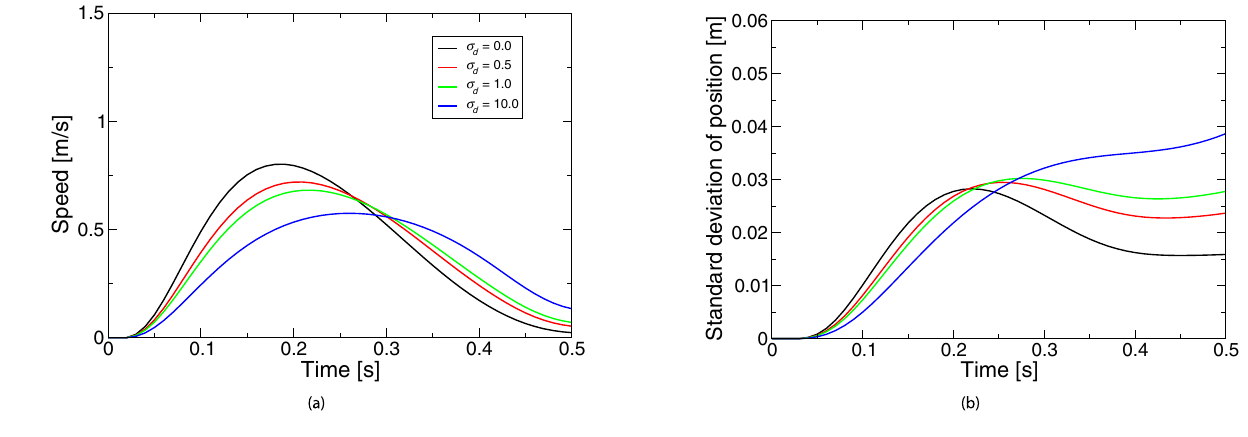
Figure 2. Simulated movements based on the extended LQG for the coefficient σ d of state-dependent observation noise: ( a ) speed, ( b ) positional variability. The legend of the subfigure ( b ) is the same as the subfigure ( a ).